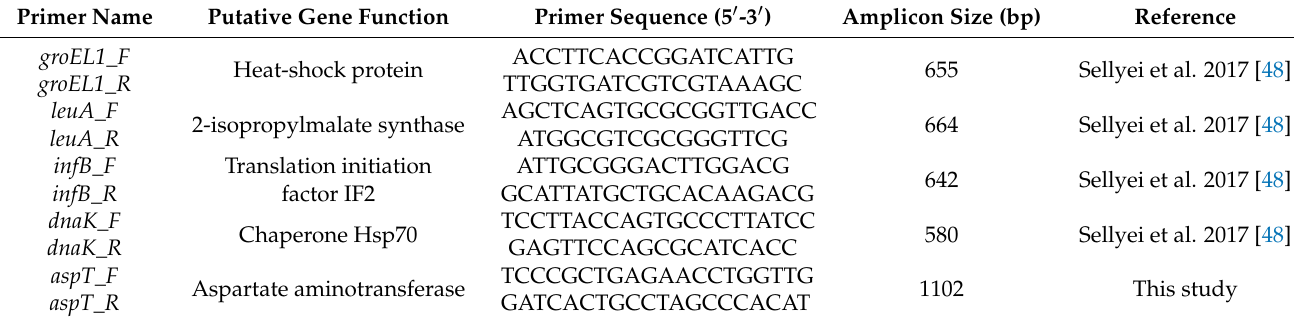
Figure 1. The location of the five genes used for the MLSA at the complete genome map of the Table 1. Oligonucleotide sequences of the primers used for amplification and sequence analysis a .